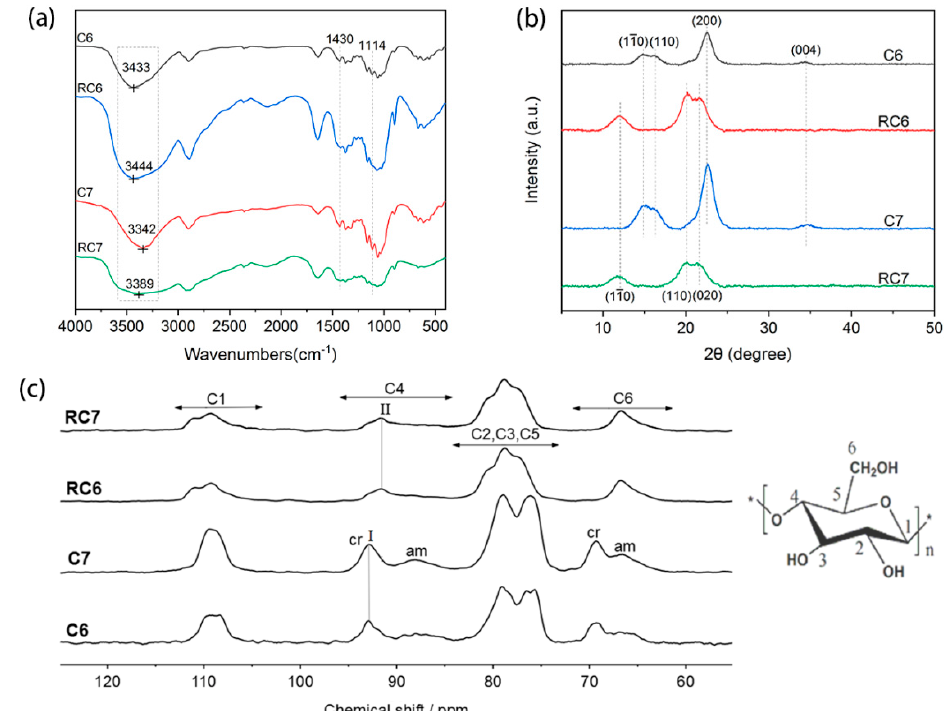
Figure 5. The structure analysis of cellulose samples (cellulose before and after regeneration) in THDS: ( a ) The FT-IR spectra of cellulose samples; ( b ) the XRD spectra of cellulose samples; ( c ) the solid-state 13 C NMR spectra of cellulose samples: cr corresponding to the crystalline signal; am corresponding to amorphous signal; I corresponding to cellulose I crystal form; II corresponding to cellulose II crystal form.